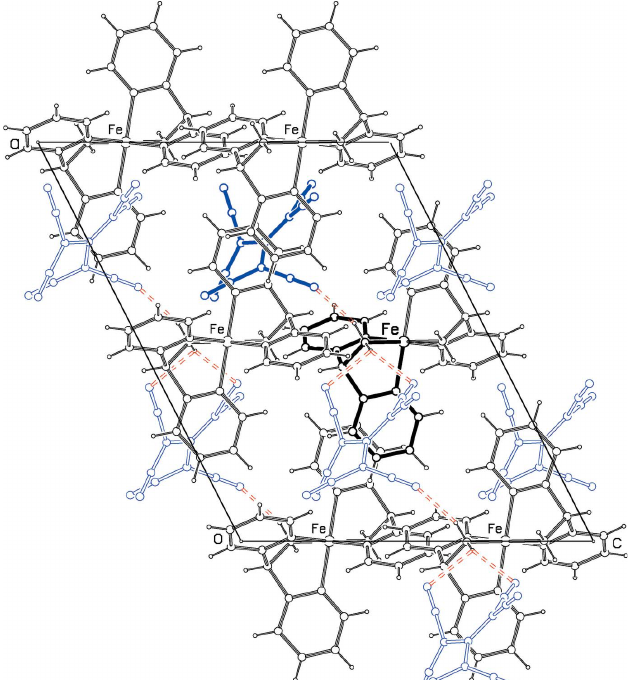
Figure 2 Projection of the structure down the b axis, with weak N—H (cid:3)(cid:3)(cid:3) N interactions shown as dashed orange bonds. Only one disorder mate for the anion is shown. Cations have more solid bonds. The asymmetric unit is shown in bold.